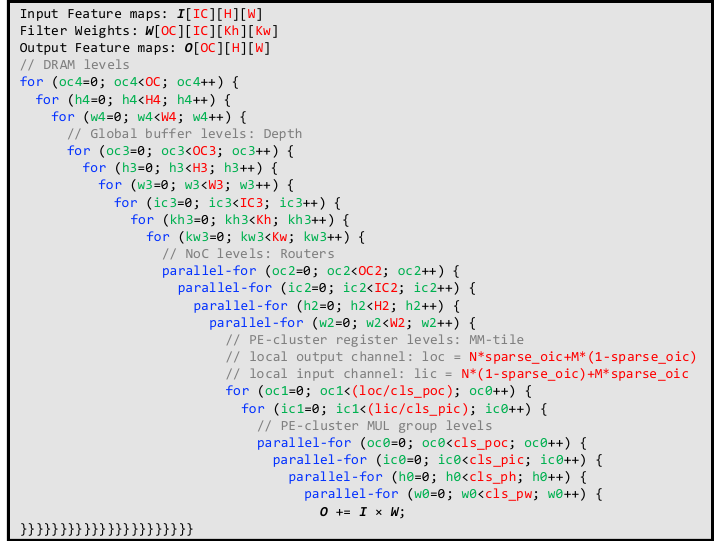
Figure 10. The pseudo-code for the overall